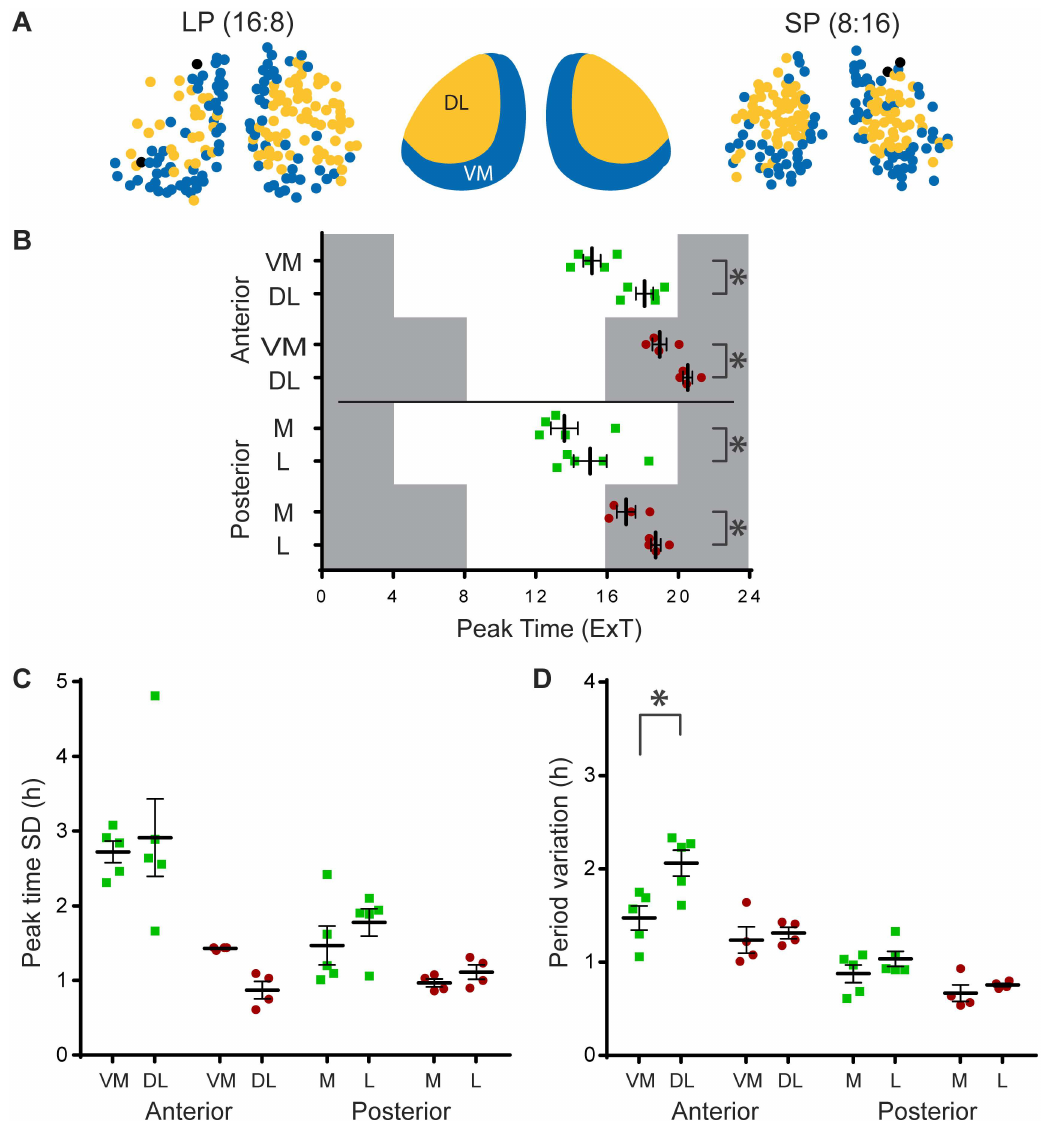
Fig 5. Functional clusters show distinct spatial distribution and region specific rhythm characteristics. (A) Representative examplesof the communitiesdetected by an advanced,unsupervised method for correlationmatrix analysis[15]. The community detectionmethod automatically dividedthe SCN in two distinct regions, a ventromedial (VM) and dorsolateral (DL) regionin the anterior SCN (middle panel), and a medial(M) and lateral (L) regionin the posterior SCN, in both long (LP; left panel), and short photoperiod(SP, right panel). (B) Peak times in externaltime (ExT) were averagedper region, per slice. Darkness and light of the previous light regime are representedby grey and white background respectively. (C) Phase distribution, definedas peak time standard deviation(SD), was calculatedper region, per slice. (D) Single-cellperiodvariabilitywas averagedper region, per slice. All data are shown for the VM and DL regionin the anterior, and M and L region in the posterior SCN, in LP (green squares) and SP (red circles). Black bars indicatemean ± SEM; * p <